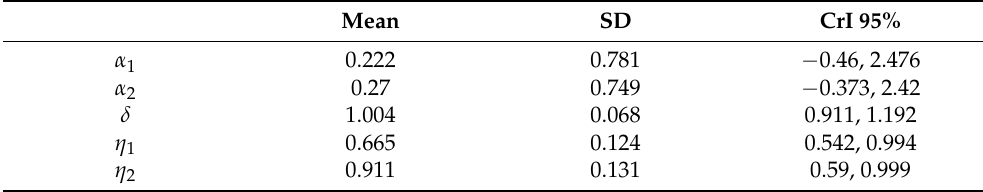
Table 2. Posterior distribution of the parameters of spatial joint